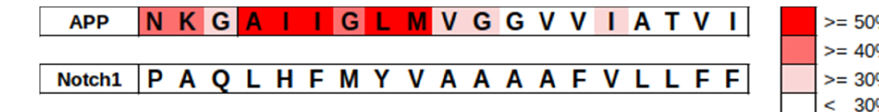
Figure 7. The sequence alignment of amyloid substrates (indicated as APP) in contact with cholesterol with the corresponding Notch1 sequence. The particular residues of substrates in contact with cholesterol are marked on the APP sequence in shades of red. The percentage values are averaged over all MD simulations with a 50% cholesterol concentration, and the color scale is shown on the right.